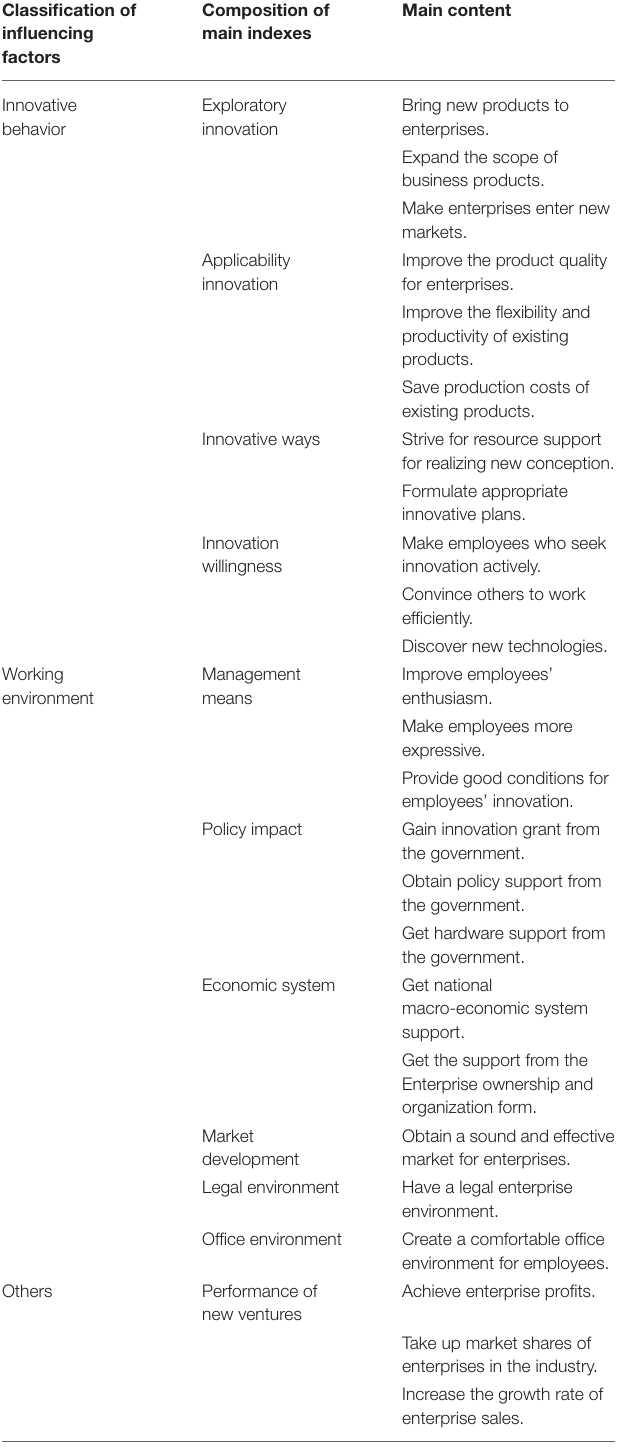
TABLE 1 | Main composition of questionnaires for employees. Classification of influencing